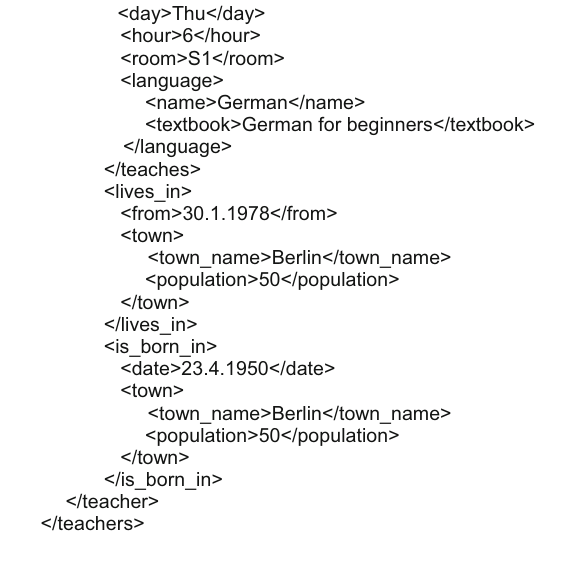
Fig. 2 XML document